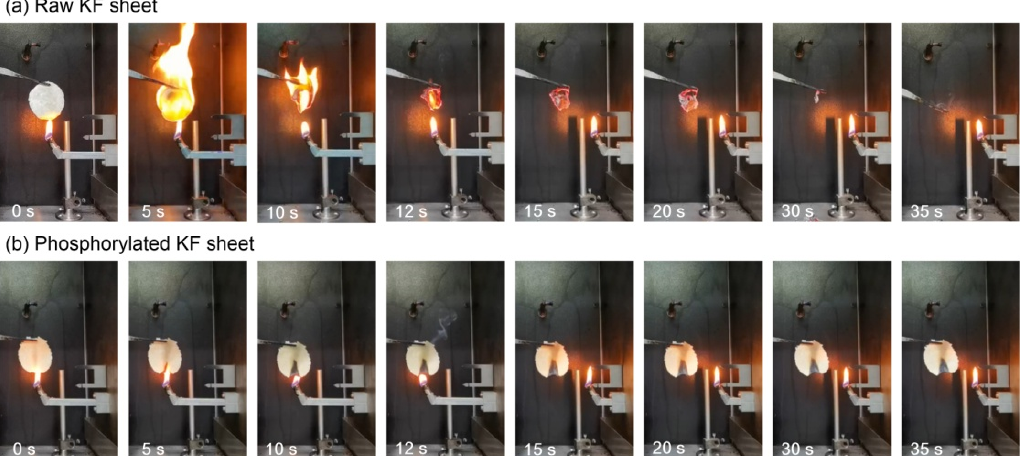
Figure 9. Flammability test of raw KF sheet ( a ) and phosphylated KF sheet obtained using 6 g PA ( b ).